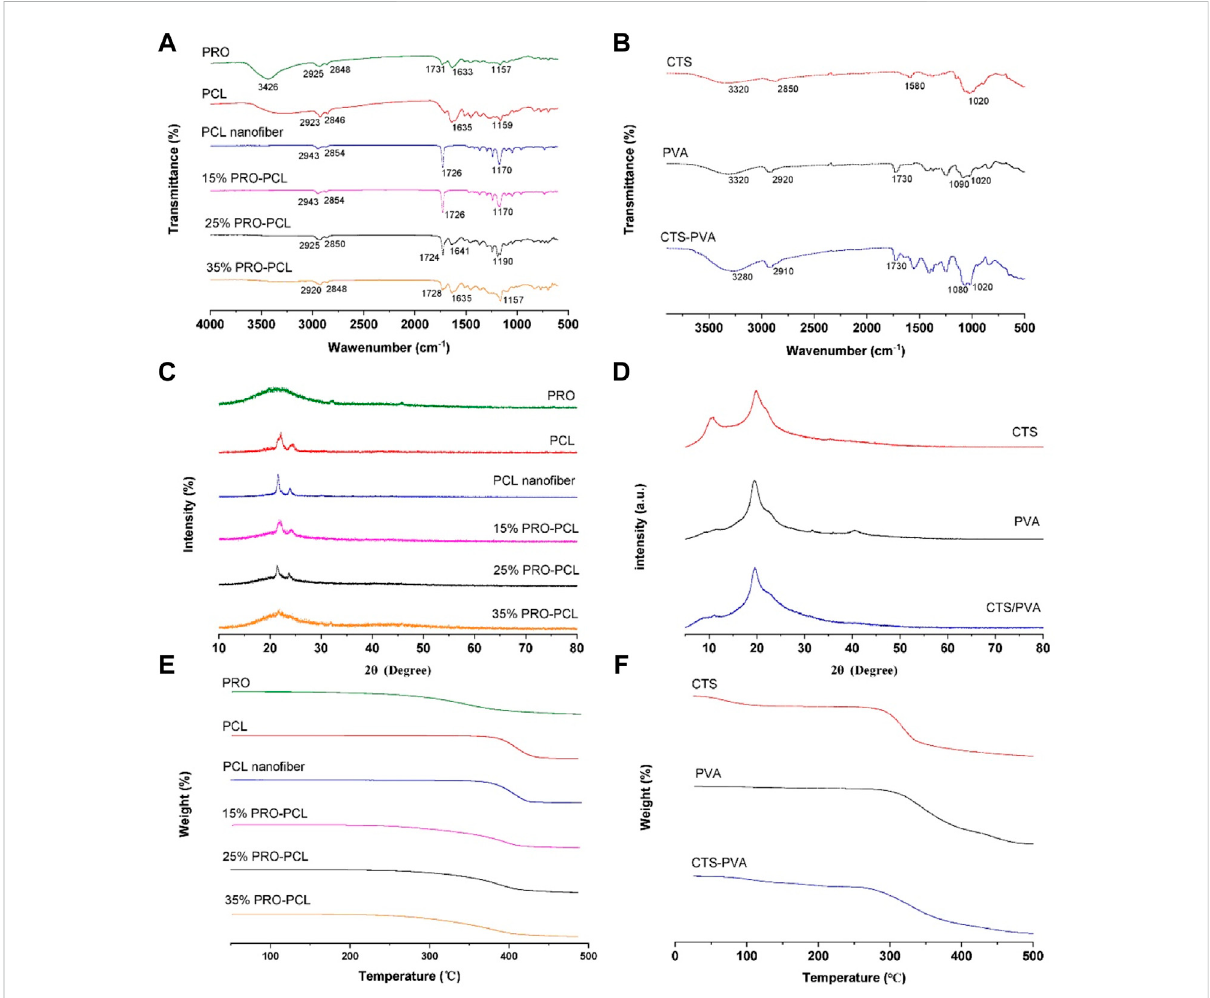
FIGURE 2 Representative image exhibiting physicochemical characterization of various membranes. FTIR spectra of PRO-PCL fi ber membranes (A) and CTA-PVA cast fi lm (B) . XRD spectra of PRO-PCL fi ber membranes (C) and CTA-PVA cast fi lm (D) . TGA spectra of PRO-PCL fi ber membranes (E) and CTA-PVA cast fi lm (F)